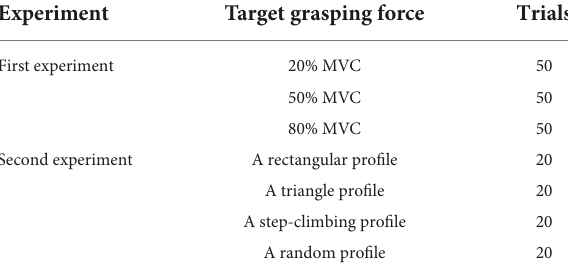
TABLE 1 Target grasping force for different